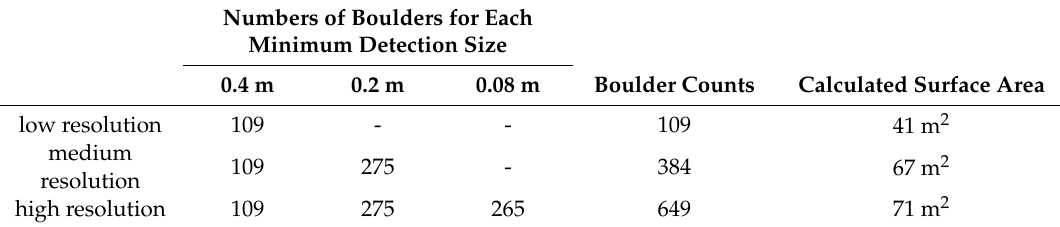
Table 3. Surface areas were calculated assuming hemispheres and average diameters are estimated using minimum detection